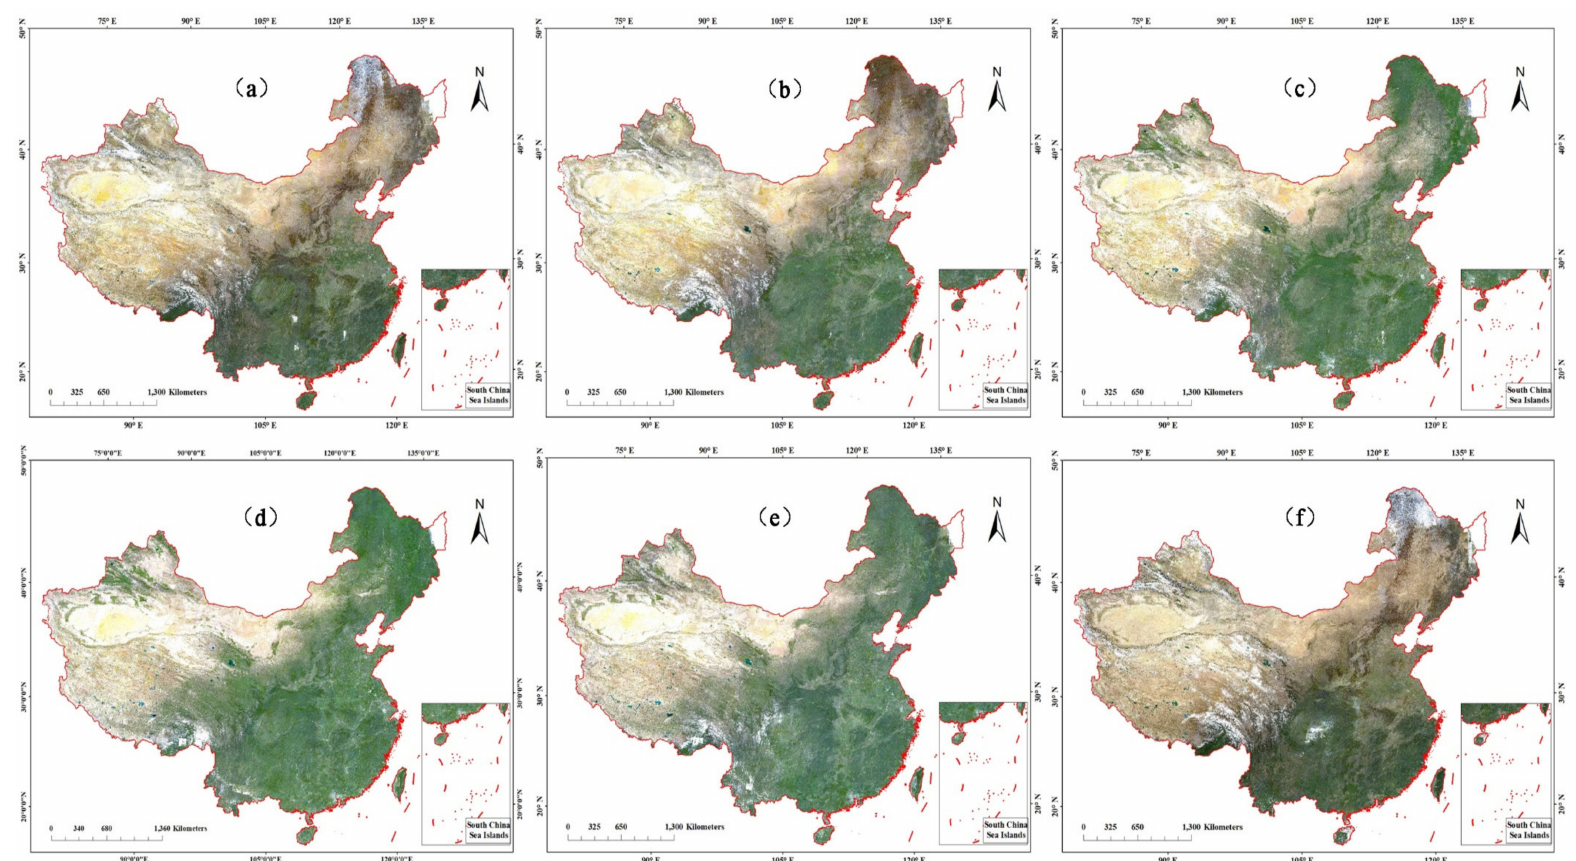
Figure 5. The bimonthly 16 m surface reflectance mosaics in the most of China in 2019 composited from the GF1-WFV ARD. ( a – f ) are January–February, March–April,